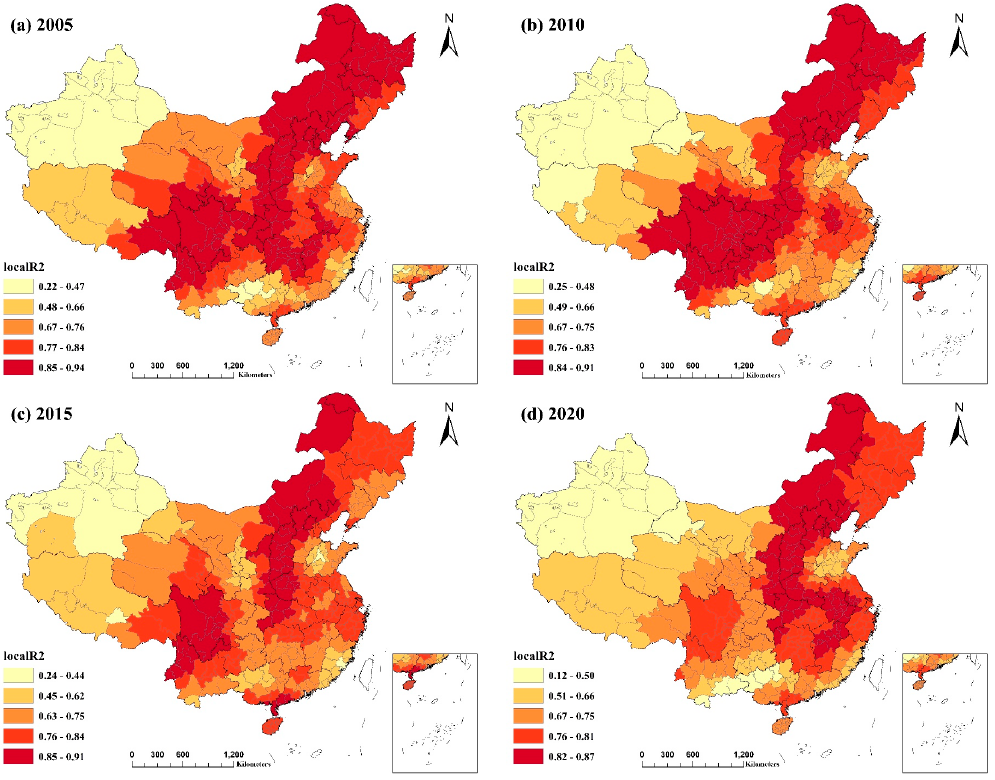
Figure 4. Spatial distribution of local R 2 values for the GWR model from 2005 − 2020: ( a ) spatial distribution of the local R 2 values of the GWR model for 2005; ( b ) spatial distribution of the local R 2 values of the GWR model for 2010; ( c ) spatial distribution of the local R 2 values of the GWR model for 2015; ( d ) spatial distribution of the local R 2 values of the GWR model for 2020.